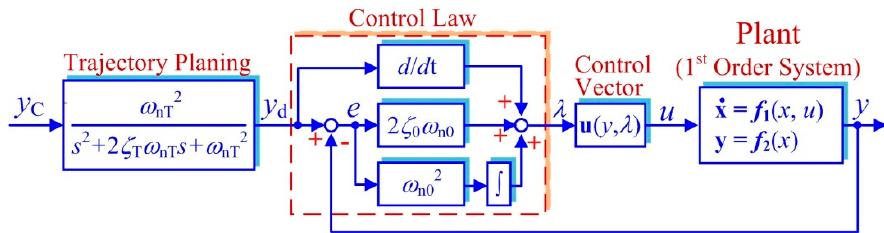
Figure A1. Concept of the differential flatness based control approach of the 1st order system.